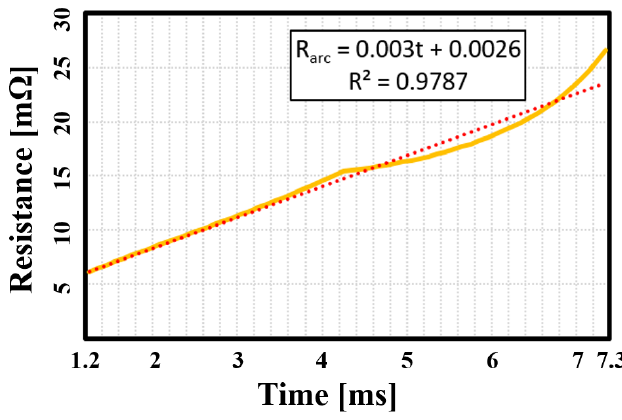
Figure 7. Resistance ( R arc ) between the contacts in section II.